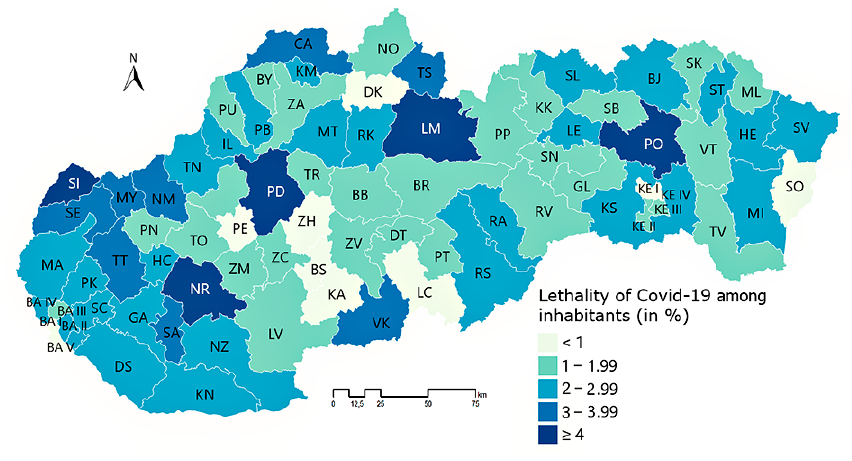
Figure 8. Lethality of Covid-19 among inhabitants in districts of Slovakia in 2020 Source: ŠÚ SR (2021), Institute of Health Analyses IZA (2021a, 2021b) The abbreviations of districts: BB - Banská Bystrica, BS - Banská Štiavnica, BJ - Bardejov, BN - Bánovce nad Bebravou, BR - Brezno, BA - Bratislava, BY - Bytča, CA - Čadca, DT - Detva, DK - Dolný Kubín, DS - Dunajská Streda, GA - Galanta, GL - Gelnica, HC - Hlohovec, HE - Humenné, IL - Ilava, KK - Kežmarok, KN - Komárno, KE - Košice, KS - Košice-okolie, KA - Krupina, KM -